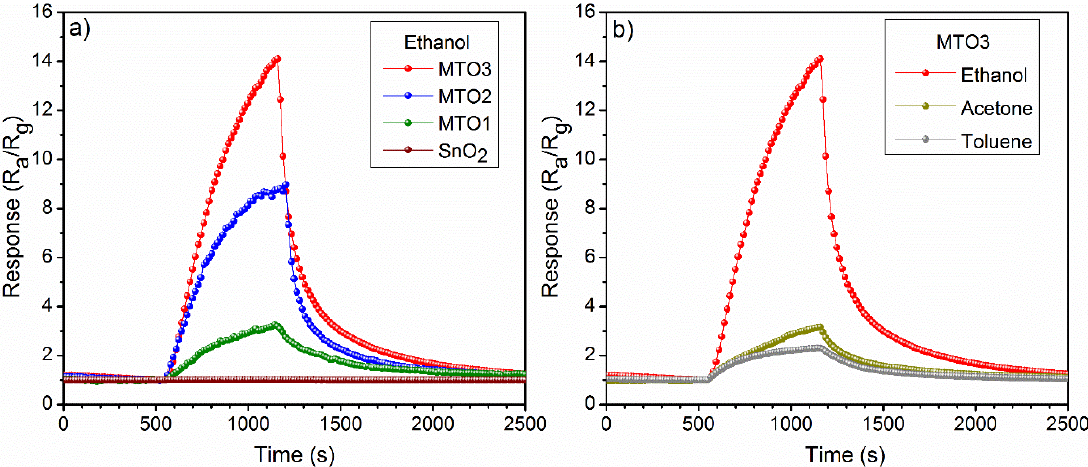
Figure 8. Response of the ( a ) non-doped and Mg-doped SnO 2 films to 80 ppm of ethanol and ( b ) MTO3 response to 80 ppm of toluene, acetone, and ethanol recorded at 160°C.